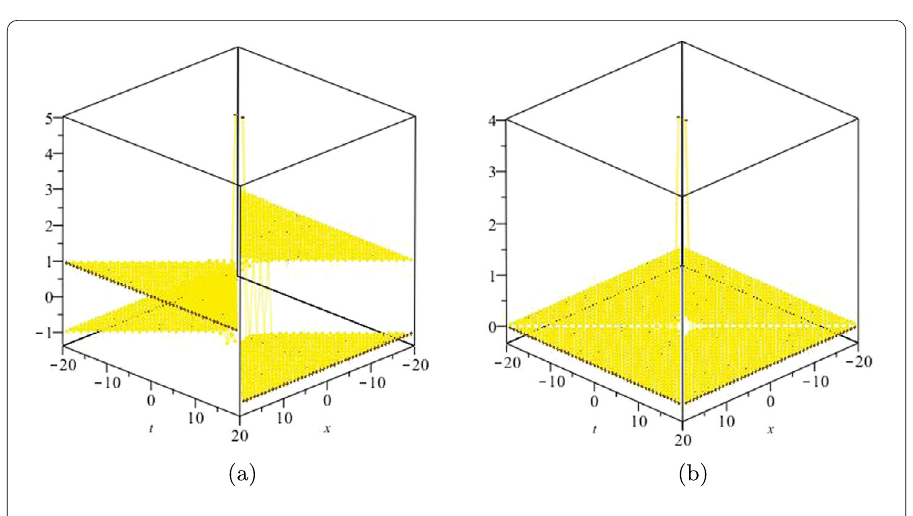
Figure 2 3D plot of (26), with α = 0.75, μ = 1.5, k = 2, A 0 = B 1 = 1,